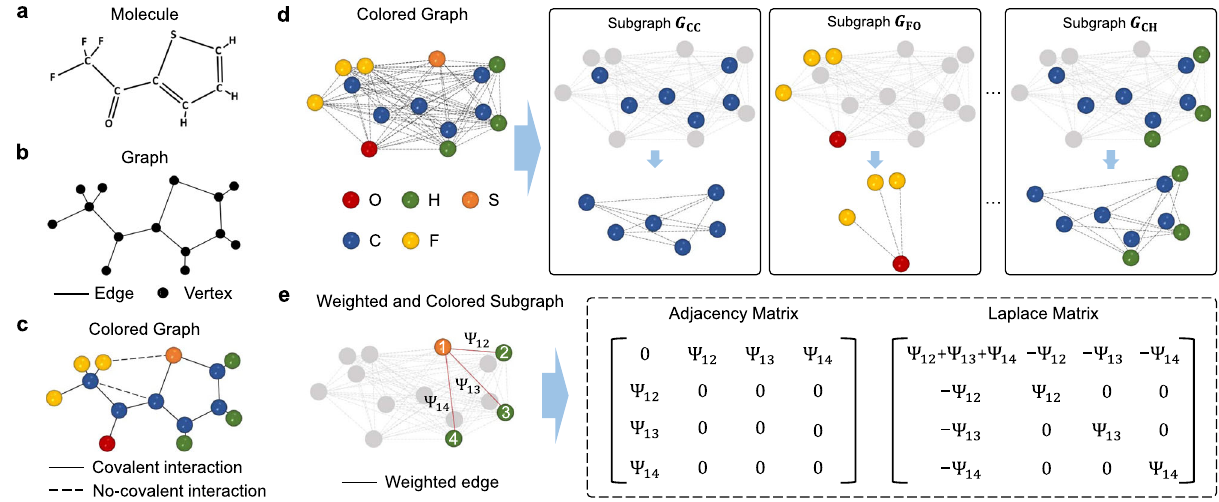
Fig. 3 Illustration of weighted colored element-speci fi c algebraic graphs. a The molecular structure of 2-Tri fl uoroacetyl. b , c Represent a traditional graph representation and a colored graph representation, respectively. d Illustration of the process of decomposing a colored graph into element-speci fi c CC, FO, and CH subgroups, where element refers to the chemical element in this study, e.g., H, C, N. e Illustration of weighted colored element-speci fi c subgraph G SH , its adjacency matrix, and Laplacian matrix, where Ψ refers to the weight of the edge in